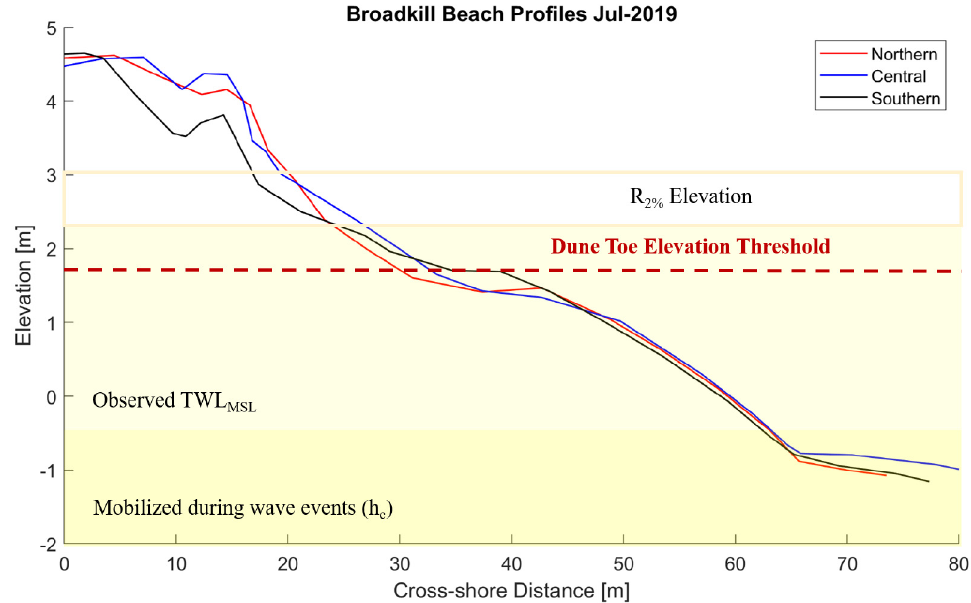
Figure 4. Topobathymetric profiles were completed in July of 2019 for the northern, central, and southern portions of the study site. The yellow boxes indicate areas of submergence during normal and hydrometeorological conditions, relative to MSL.